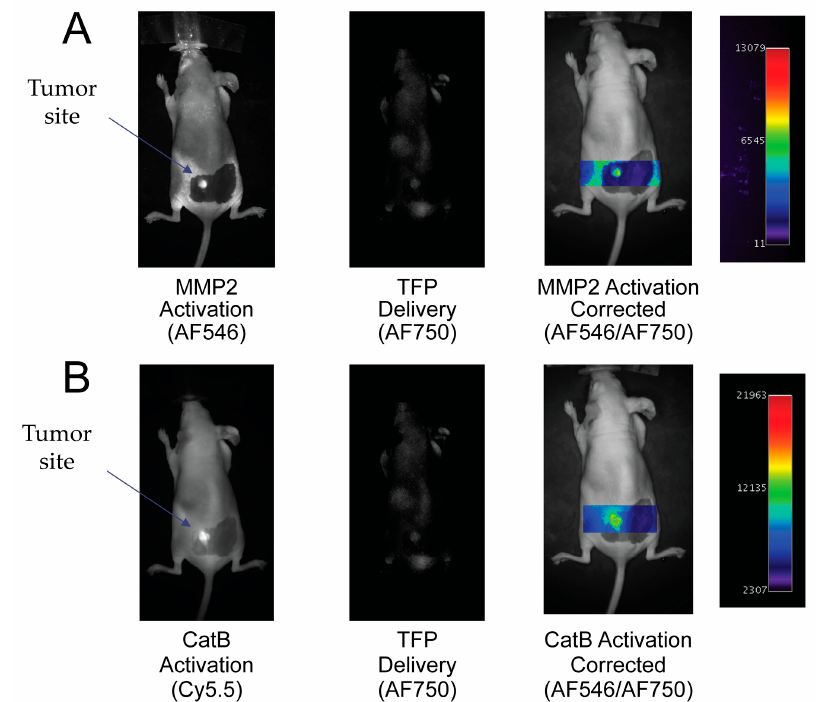
Figure 6. In vivo imaging of MMP2 and CatB activities with the Triple Fluorochrome Probe (TFP). ( A